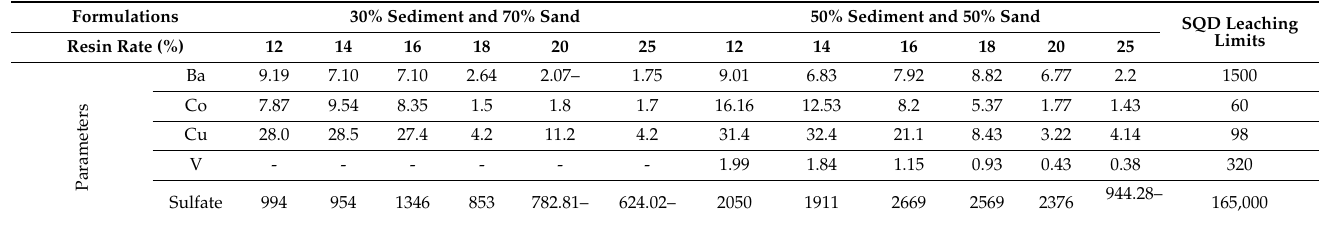
Table 6. Comparison of the cumulative release of Ba, Co, Cu, V and sulfates (mg/m 2 ) at 64 days in the monolith leaching test with regulatory leaching limits established in the Netherlands within the Soil Quality Decree